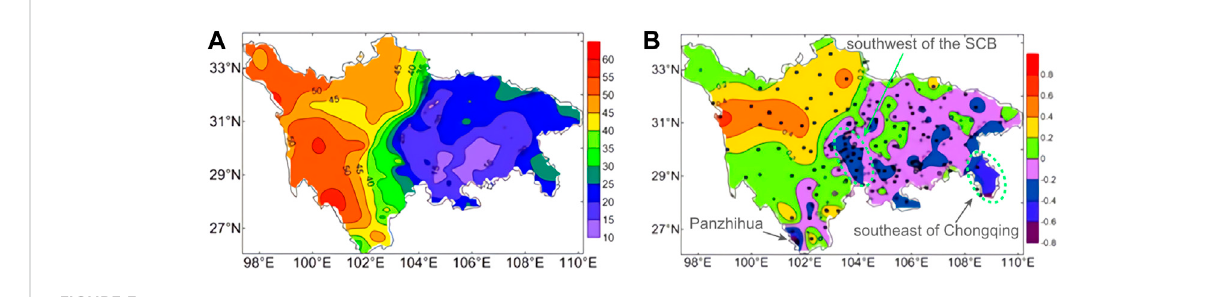
FIGURE 3 Distribution of (A) atmospheric visibility and (B) atmospheric visibility variability in the SCB and its surrounding areas over the 51 years (1960- 2010). The makers *, C , and ○ indicate passing the 99%, 95% and 90% con fi dence tests, respectively.